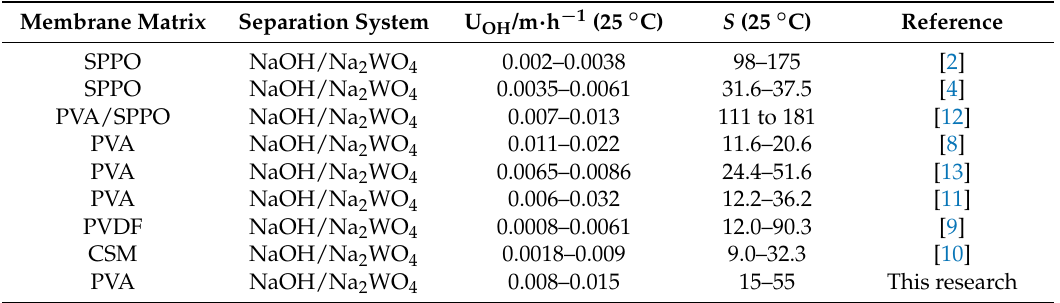
Table 4. U OH and S of as-prepared membranes and previously reported membranes. Membrane